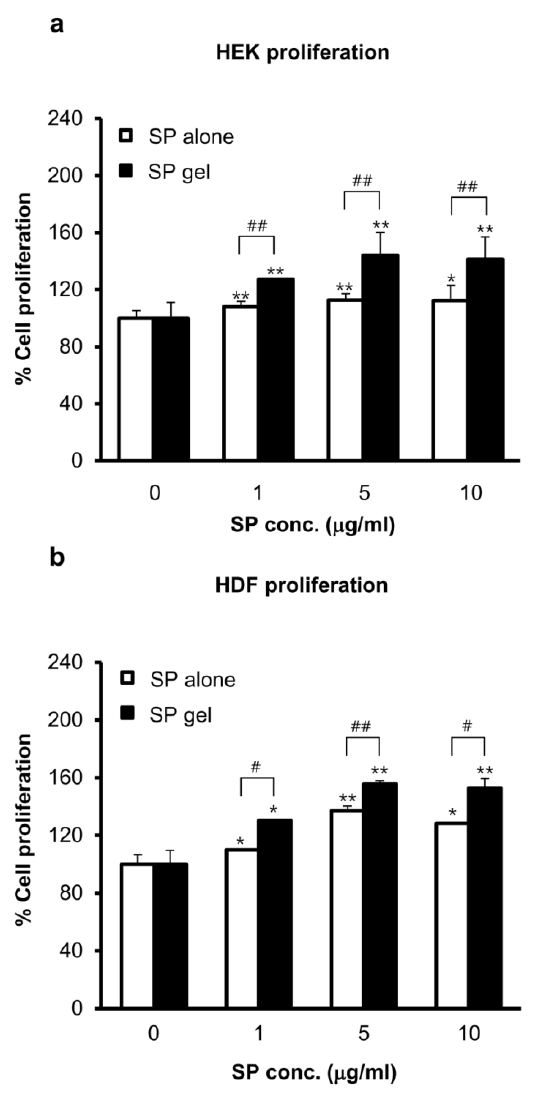
Figure 3. SP gel ‐ induced cell proliferation. ( a , b ) HEK and HDF proliferation induced by SP gel. After incubation for 24 h with indicated concentrations of SP alone or SP gel, the viability of HEKs ( a ) and HDFs ( b ) was assessed with the MTT assay. Values represent the mean ± SD of three independent experiments performed in duplicate. * p < 0.05, ** p < 0.01 vs. PBS ‐ containing medium without SP; # p < 0.05, ## p < 0.01 vs. SP alone.